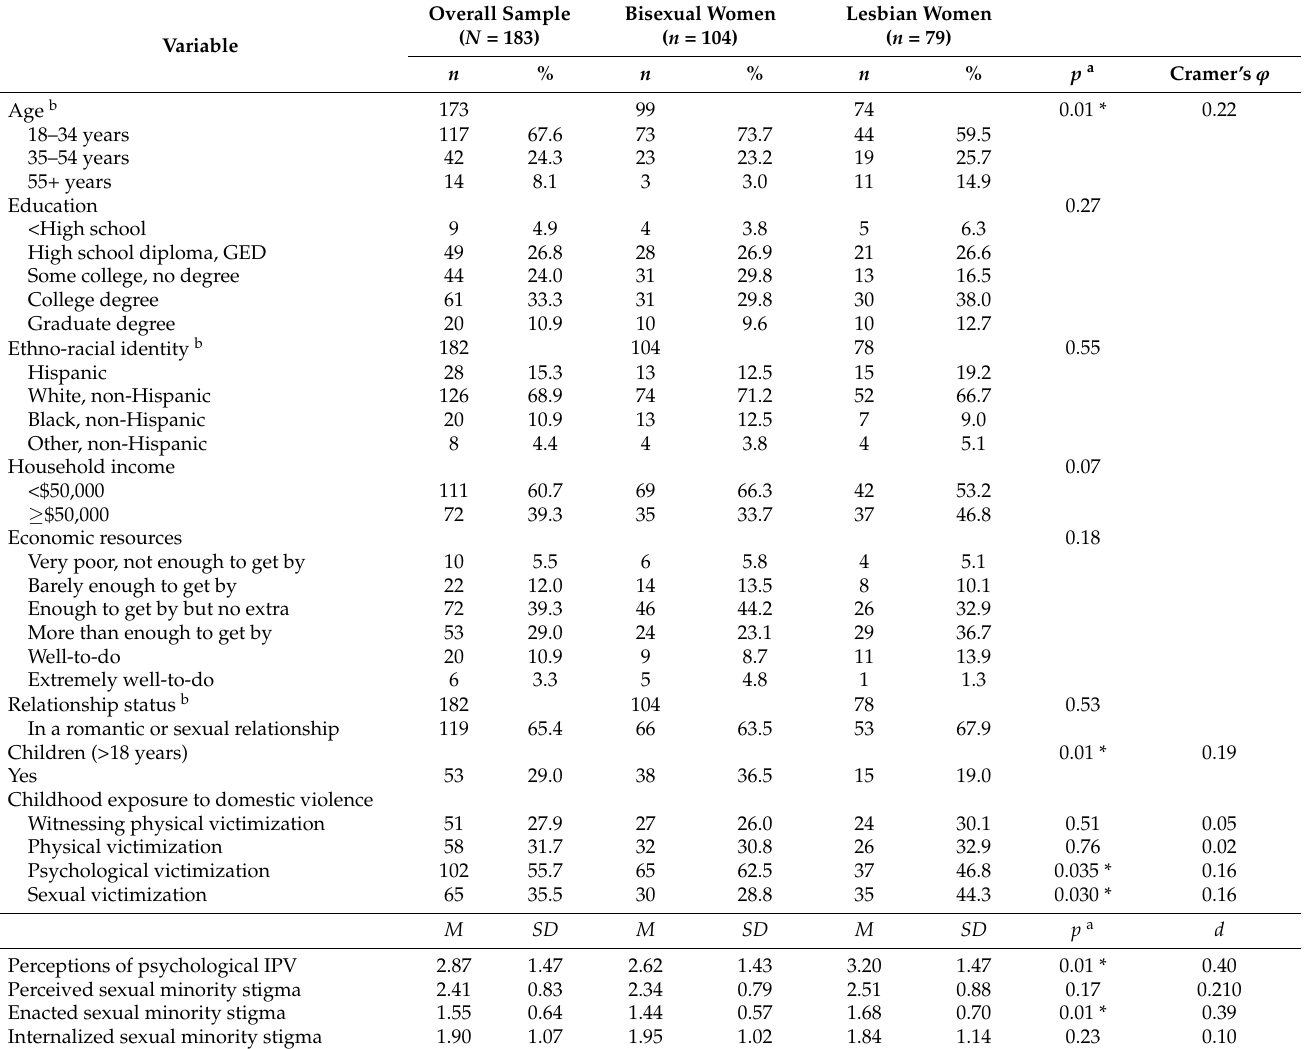
Table 2. Sociodemographic and bivariate differences by sexual